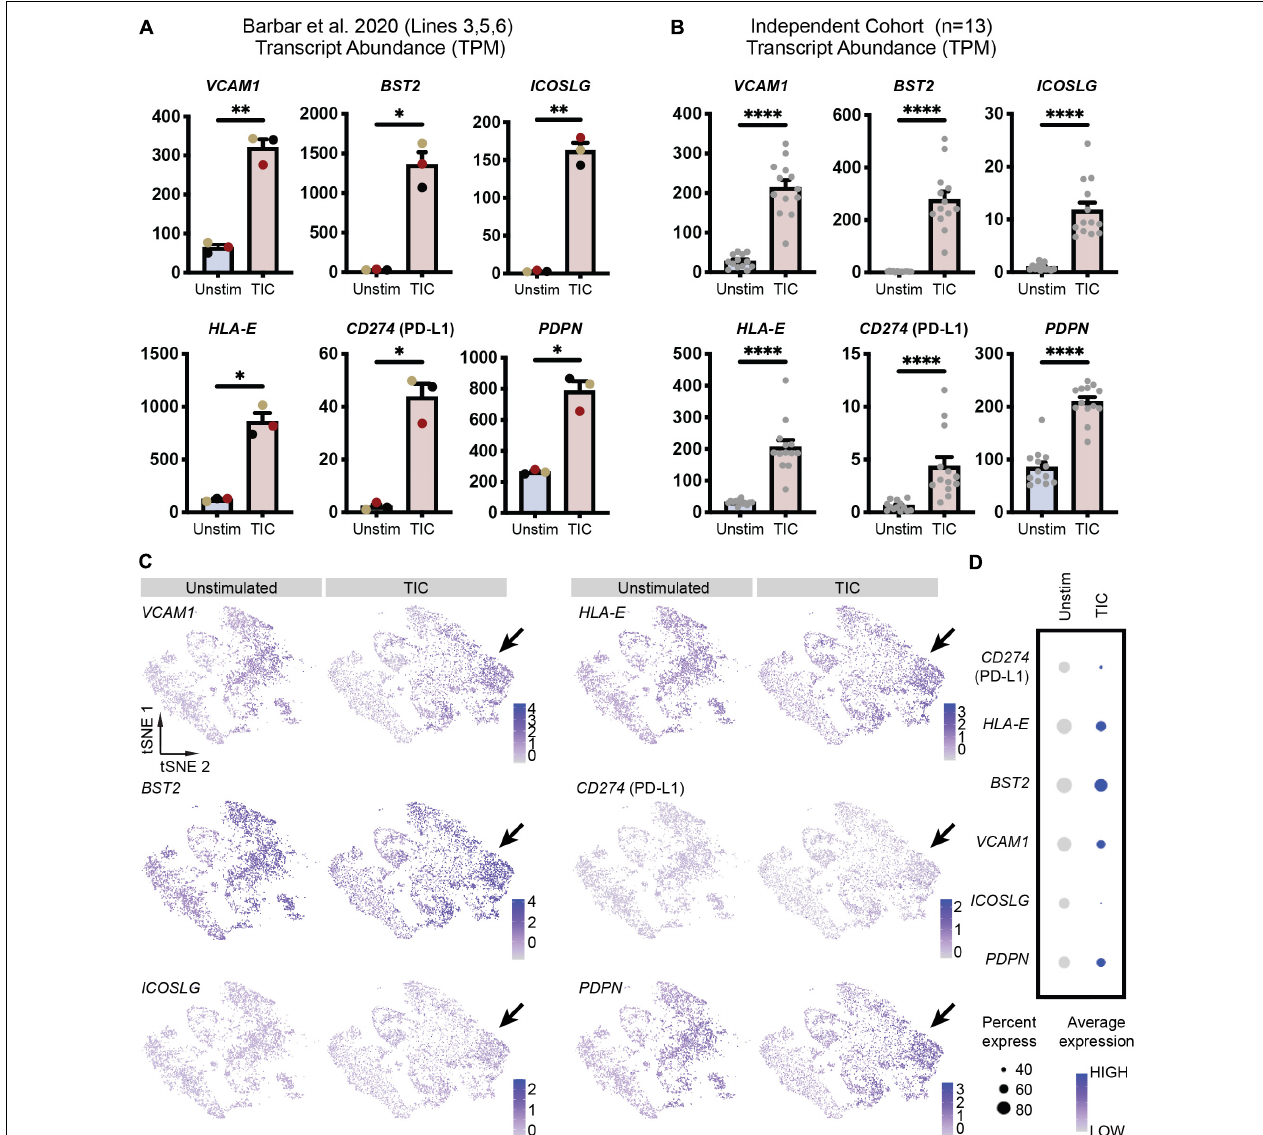
FIGURE 3 | Novel reactive astrocyte markers are upregulated at the transcriptional level. (A) Transcript abundances in transcripts per million (TPM) for each of the six genes are plotted to visualize marker expression levels for each individual line ( n = 3, line 3 = black, line 5 = yellow, line 6 = red from Barbar et al., 2020a). Individual dots are means of three technical replicates for each line; error bars represent standard error of means. p -value was calculated using a two-tailed Welch’s t -test. *, p -value < 0.05; **, p -value < 0.01. (B) Transcript abundances (in TPM) for each of the six genes are plotted to visualize marker expression in hiPSC-derived astrocytes from an independent cohort of 13 lines (individual replicates shown as dots). Error bars represent standard error of means. P -value was calculated using a Wald test through DESeq2 and adjusted for multiple comparisons using the Benjamini and Hochberg method. ****, p -value < 0.0001. (C) Feature plots of CD49f + hiPSC-derived astrocyte scRNA-seq (Barbar et al., 2020a) demonstrates increased expression of each marker’s associated gene in TIC-induced reactive astrocytes compared to unstimulated astrocytes. Arrows highlight clusters most associated with TIC-stimulation and having the greatest upregulation of putative reactive astrocyte markers. (D) Dot plot showing genes enriched in TIC-induced reactive astrocytes and unstimulated astrocytes. Each row is an individual marker